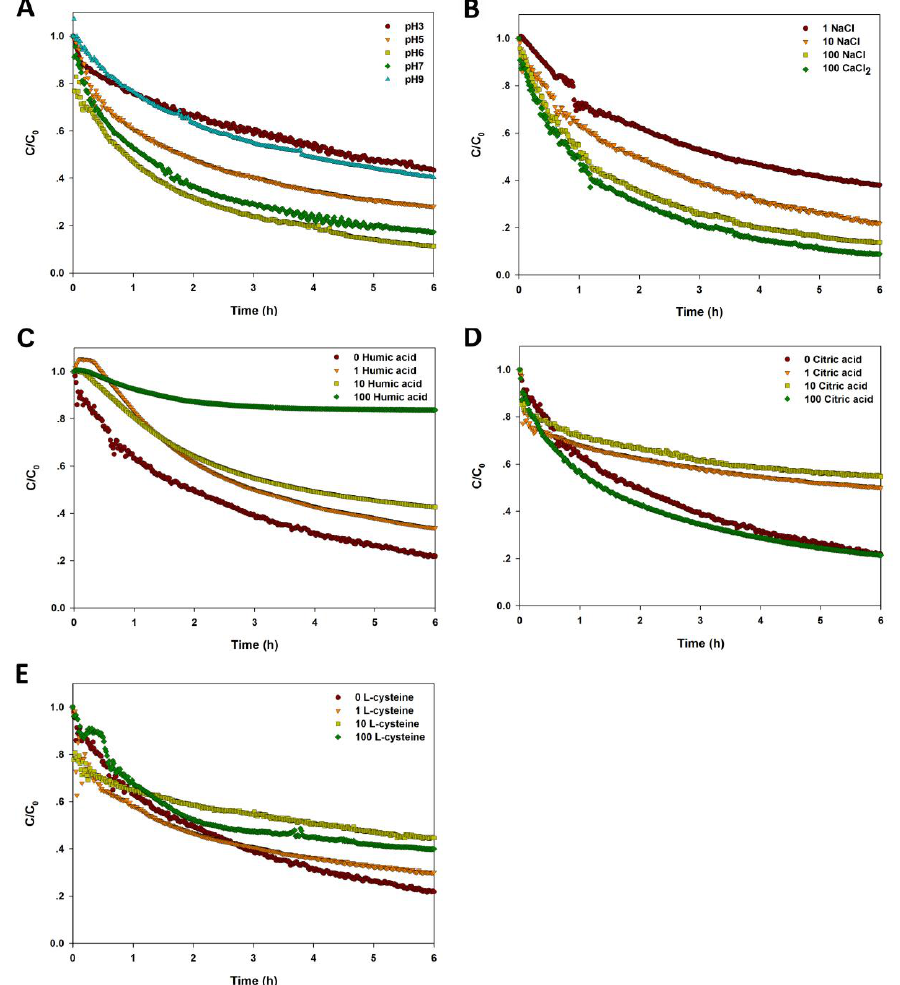
Figure 4. Sedimentation of CuO NPs (100 mg/L) in the solution with varying pH ( A ); ionic strength and ionic valence ( B ); and different amount of humic acid ( C ); citric acid ( D ); and L -cysteine ( E ).